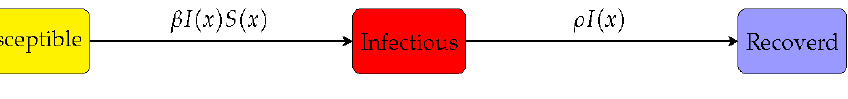
Figure 3. Flow chart of the SIR